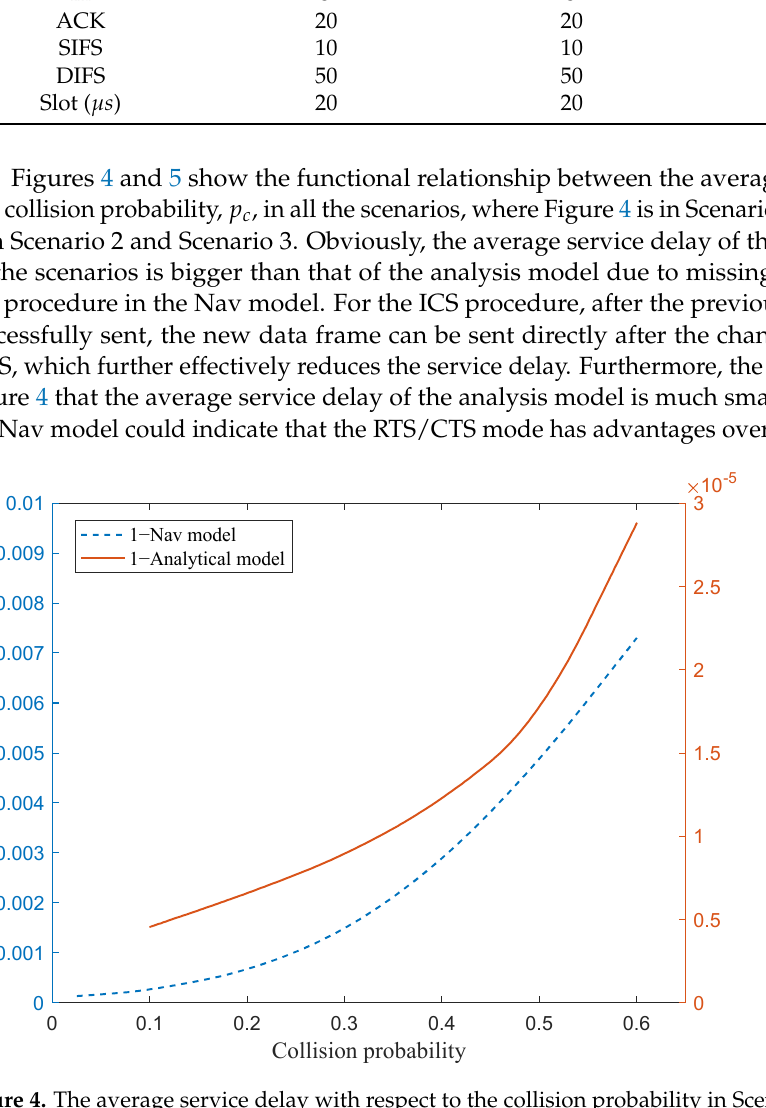
Figure 4. The average service delay with respect to the collision probability in Scenario 1.